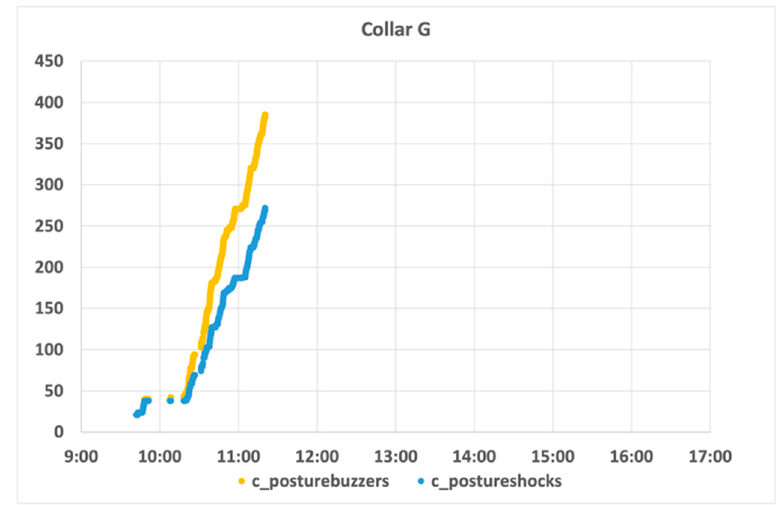
Figure 12. Collar G behaviour analysis .